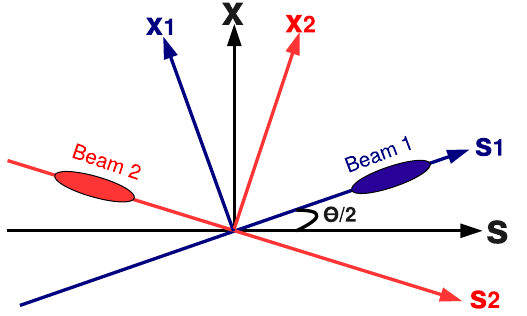
FIG. 13. (Color) Sketch of the coordinate system for the two colliding beams.